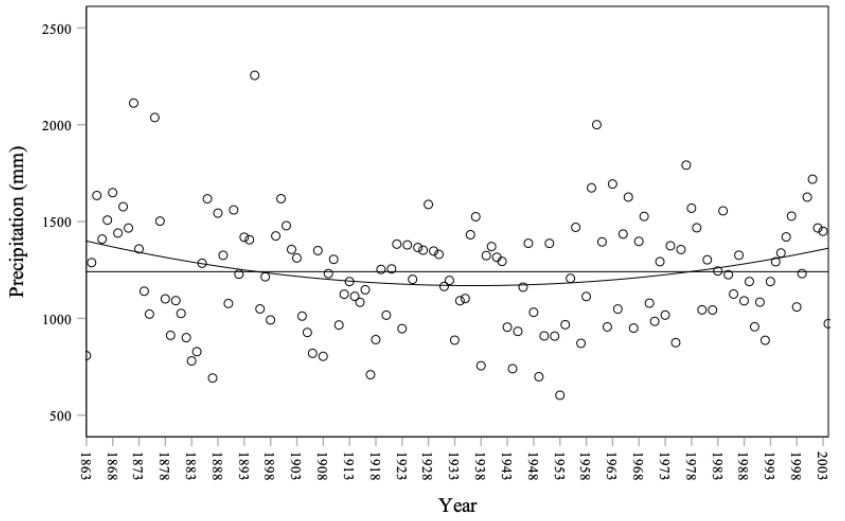
Figure 3. Projection of cumulative annual precipitation for 1863–2004 (adapted from https://www.ipma.pt/pt/oclima/series.longas/list.jsp, accessed on 20 December 2021).